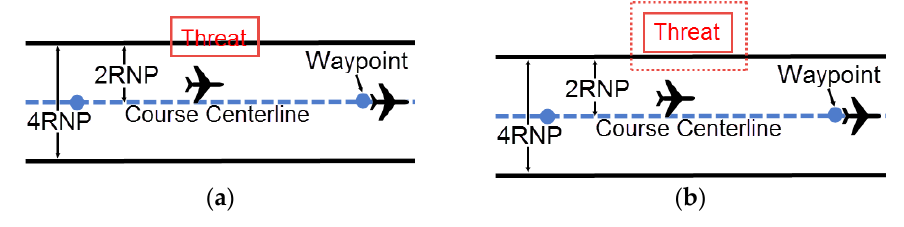
Figure 9. ( a ) Route planning with threat; ( b ) Route planning with threat area expansion.